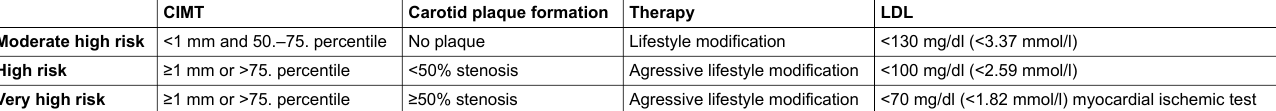
Table 2: Potential clinical implementation of CIMT-measurements with respective suggestions of therapy. Lifestyle modification = lifestyle modifications and a LDL cholesterol target of <130 mg/dl (<3.37 mmol/l); targeting to <100 mg/dl (<2.59 mmol/l) is optional. Aggressive lifestyle modification = lifestyle modifications and a LDL cholesterol target of <100 mg/dl (<2.59 mmol/l); targeting to <70 mg/dl (<1.82 mmol/l) is optional. CIMT Carotid plaque formation Therapy LDL Lifestyle modification High